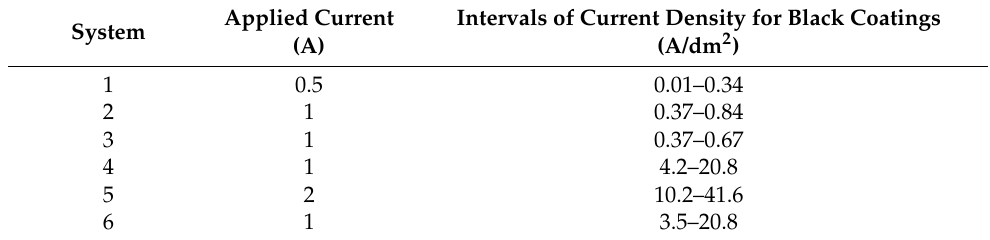
Figure 3. Hull cell samples for baths from Table 1: ( a ) bath 1, ( b ) bath 2, ( c ) bath 3, ( d ) bath 4, ( e ) bath 5, ( f ) bath 6. The higher current density was applied on to the left side of each plate. Table 2. Hull cell